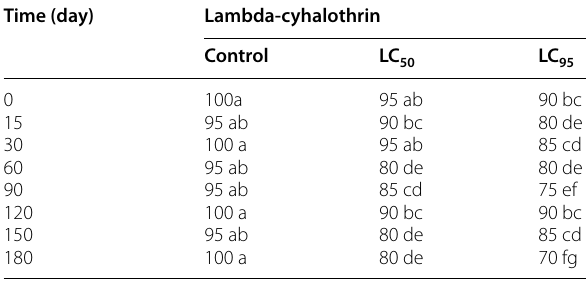
germination percentages during storage (0–180 days)